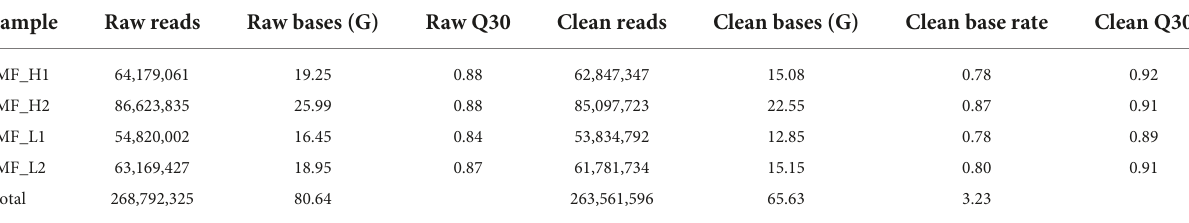
TABLE 2 Summary of the ATAC-seq